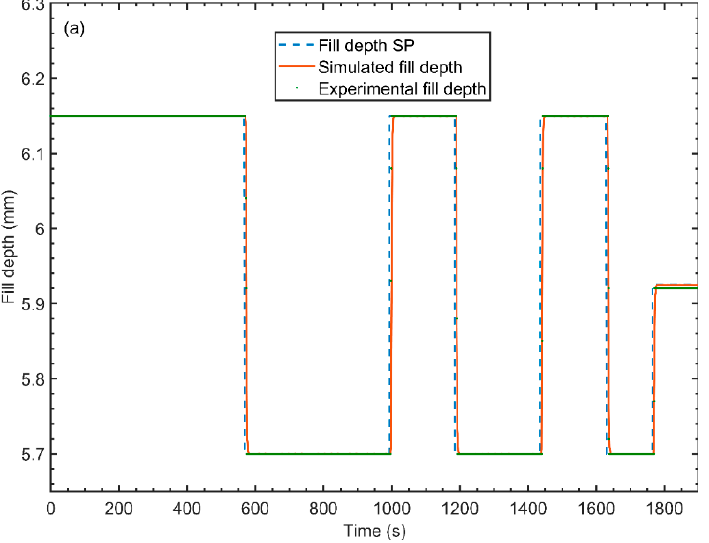
Figure 5. Cont. Figure 5.